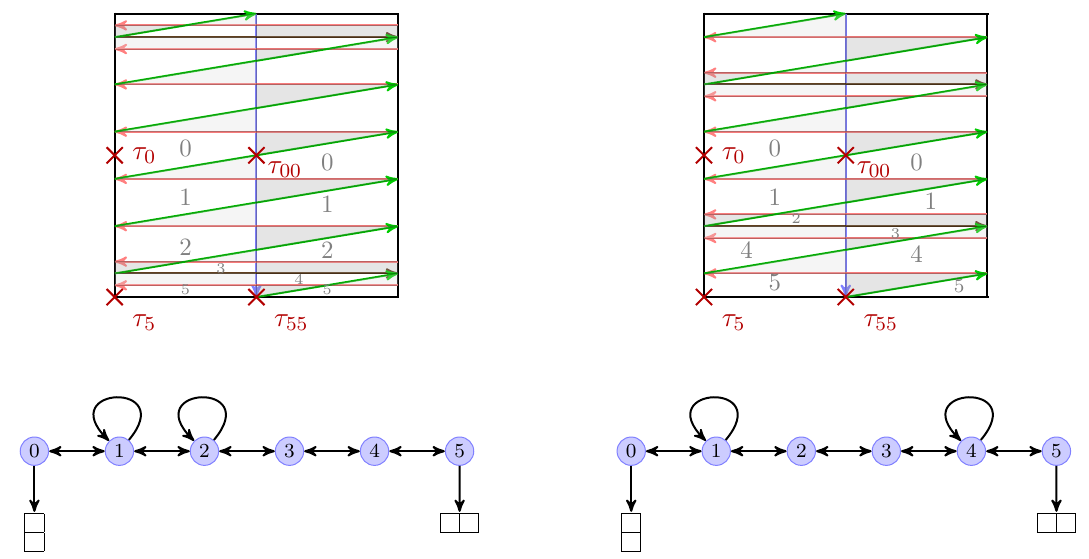
Figure 12. The two inequivalent ways of accommodating the horizontal branes for L 2 , 8 , 2 and the associated linear quivers.